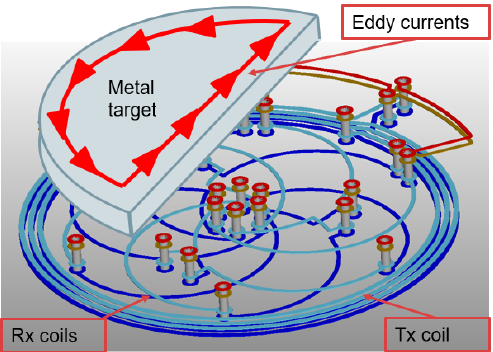
Figure 2. Concept diagram of the inductive sensor and target. The sensor consists of a circular transmitting (Tx) coil and a set of three receiving coils. The TX coil is excited by a periodic signal, thereby inducing eddy currents in the target. The receiving (Rx) coils sense a three-phase signal representative of the target